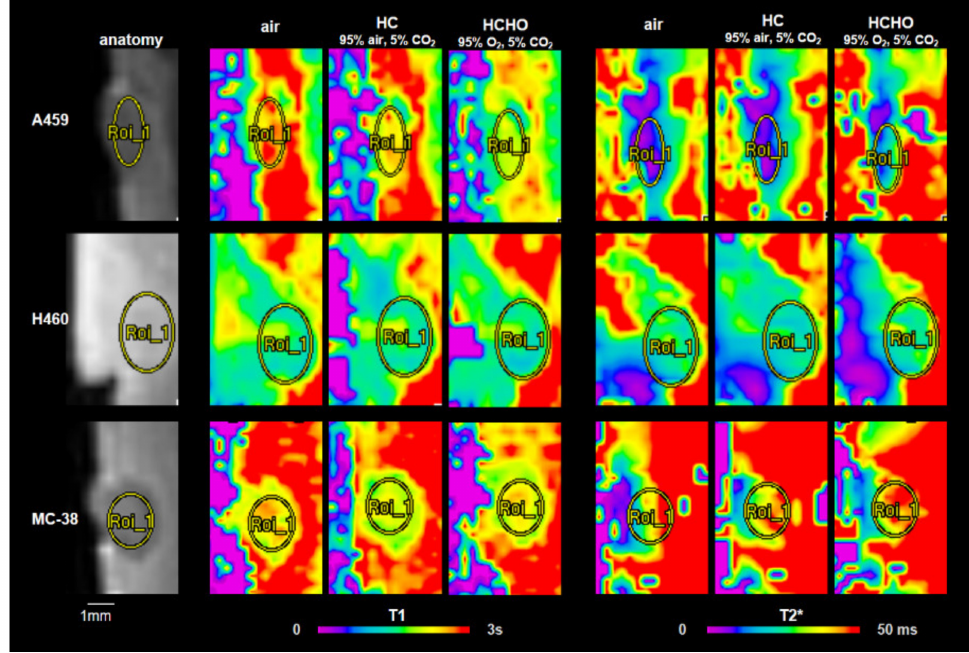
Figure 1. Representative MRI images of A549, H460, and MC-38 cell grafts grown on the CAM in ovo. Grafts are outlined on T1w anatomical reference images (left column) and quantitative color-coded T1 and T2* maps obtained while the graft was exposed to medical air, hypercapnia (HC), and hypercapnic-hyperoxia (HCHO). In H460 and MC-38 grafts, larger T1 and T2* were located in the graft center, revealing a distinct spatial distribution of T1 and T2* within the graft and response to gas